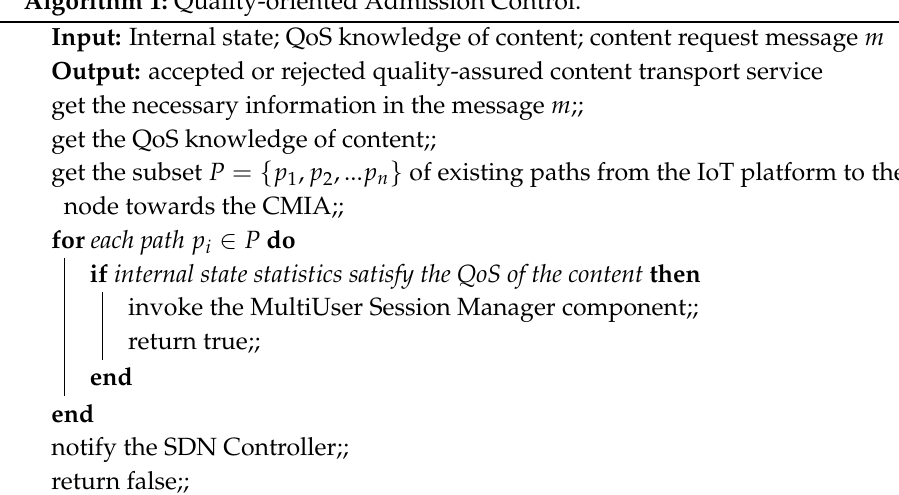
Figure 4. Sequence diagram of Quality-oriented Admission Controller (QoAC) procedures. Algorithm 1: Quality-oriented Admission